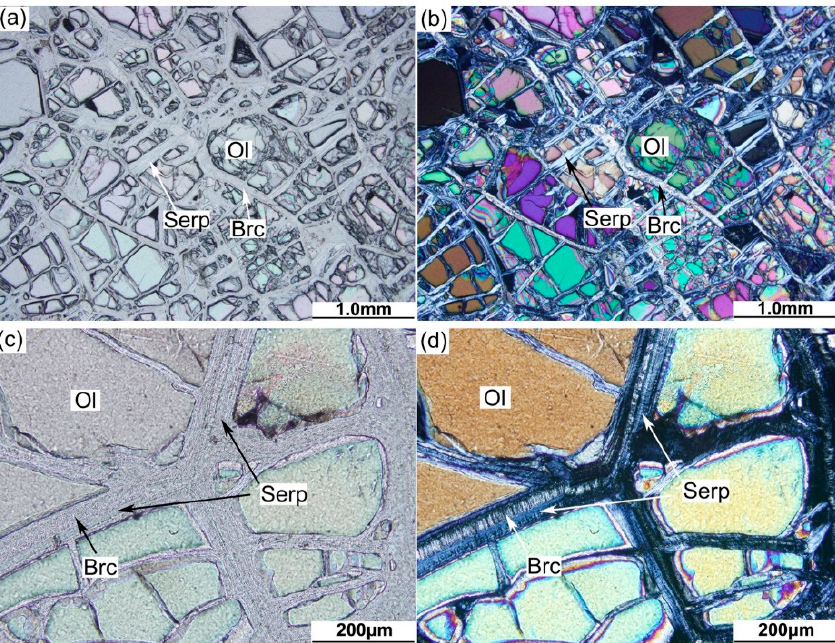
Figure 3. Photomicrographs of jianite (plane light on the left and crossed light on the right): ( a , b ) representing typical views (40 × ); ( c , d ) representing close-up views (200 × ). Ol, olivine; Serp, serpentine; Brc, brucite. Despite the strong disruption and extensive hydration, the initial crystallographic orientations of the olivine grains have been well preserved, as indicated by the almost identical extinction angles of the different fractions from the same olivine crystals. Note the ~120° dihedral angels at the triple junction shown in (c) and (d).